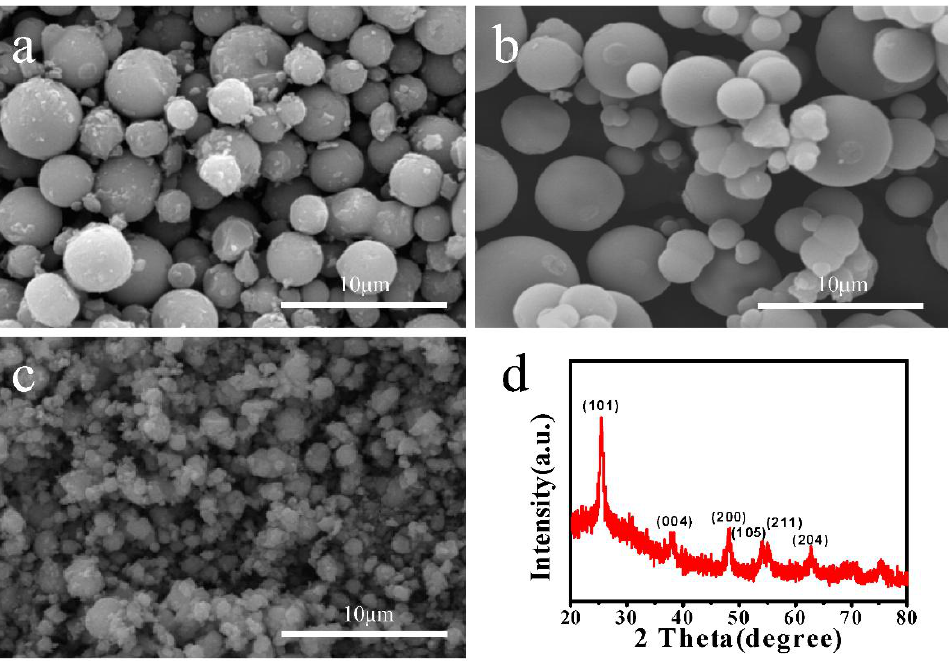
Figure 2. FESEM images of Ms prepared with different amounts of absolute ethanol: ( a ) 4.65 mL; ( b ) 9.30 mL and ( c ) 18.6 mL; ( d ) XRD pattern of Ms.